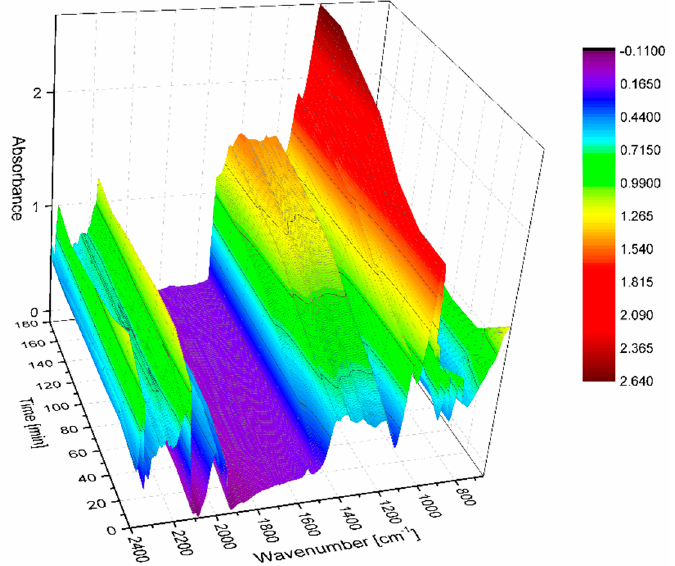
Figure 4. On-line monitored reaction spectra for glycerol oligomerization with [C 12 -mim][OAc]. As can be seen, along with the course of the reaction, the band resulting from the vibrations stretching the C–O–C groups at 1100 cm − 1 clearly grows, indicating the progress of the oligomerization reaction. The changes in the intensity of this band in relation to its absorbance at time t = 0, corresponding to the starting concentration of glycerin, were used to calculate the glycerin conversion as a function of time (Figure 5).